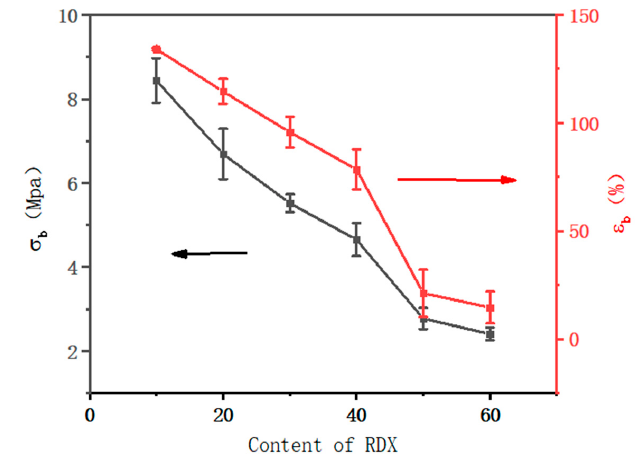
Figure 6. The curves of tensile strength and elongation at break of energetic polymer composites with di ff erent RDX contents.